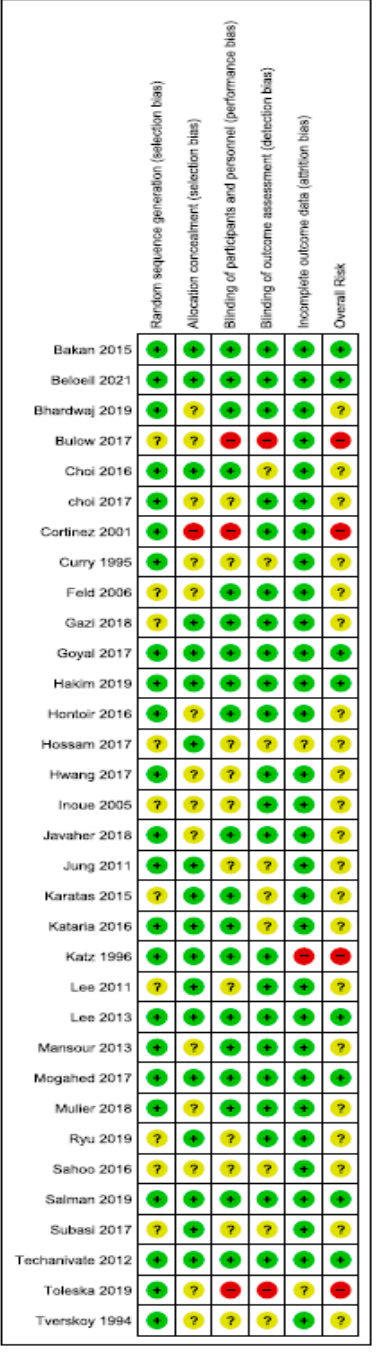
Figure 2. Risk-of-bias summary: review of authors’ judgements about each risk-of-bias item for each included